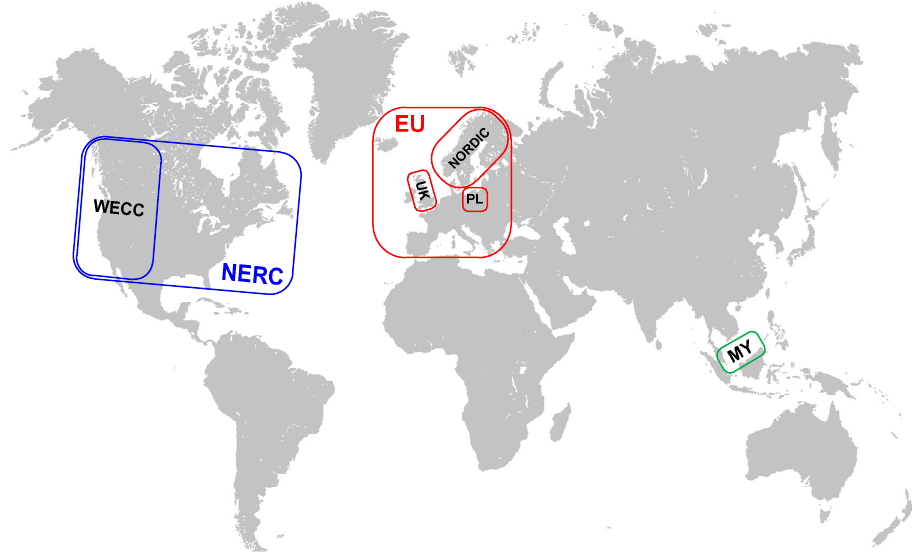
Figure 6. Areas under the jurisdiction of several grid regulatory authorities and some of their TSOs.